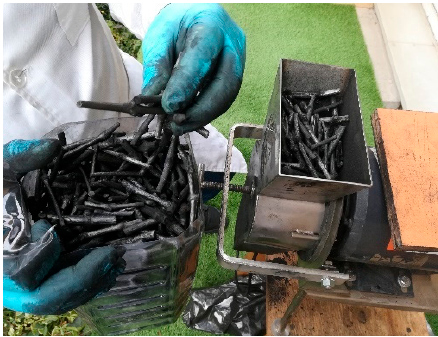
Figure 1. BC before grinding in the soil mill.